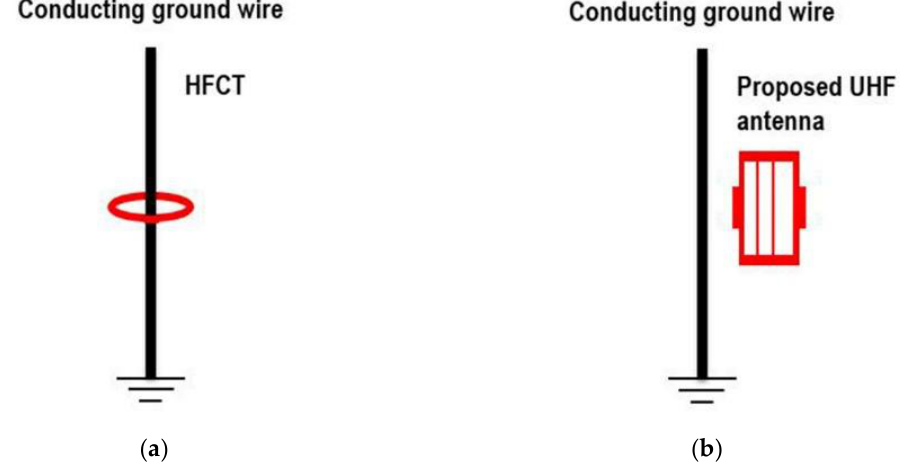
Figure 2. Conceptual diagram for the PD detection in the conducting ground wire: ( a ) HFCT and ( b ) proposed ultra-high frequency (UHF) antenna.